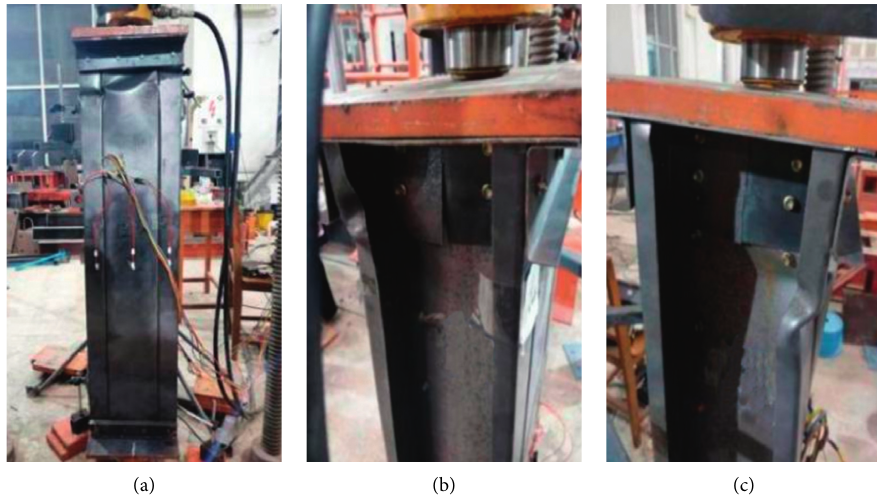
Figure 14: 4C-1 failure mode: (a) south, (b) east, and (c)